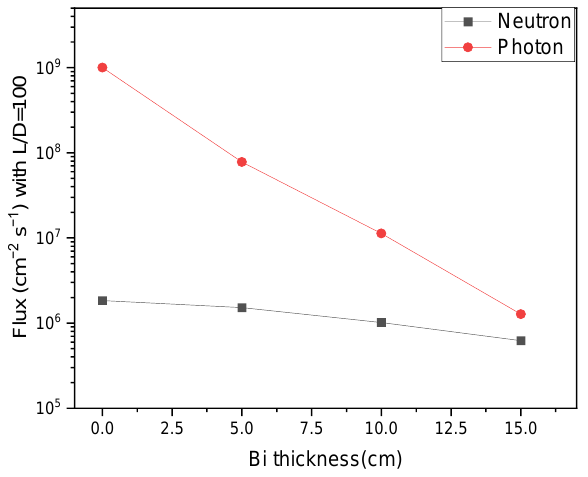
Figure 9. The variance of neutron and photon flux with different thicknesses of bismuth at 10 m away from the exit of the neutron channel (L/D = 100).